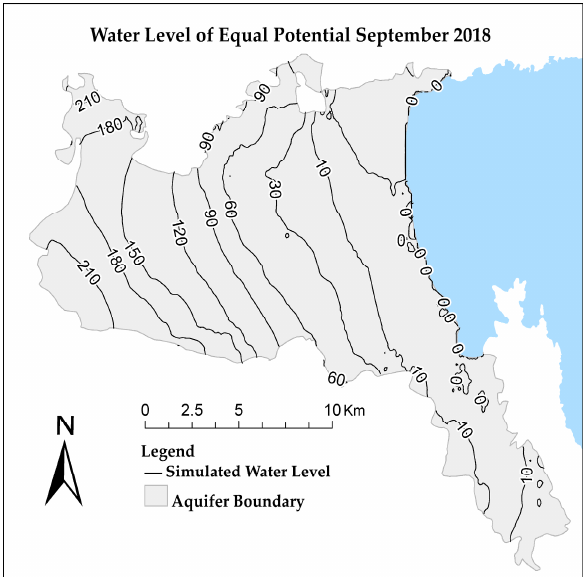
Figure 12. The water level of equal potential at the end of groundwater simulation in September